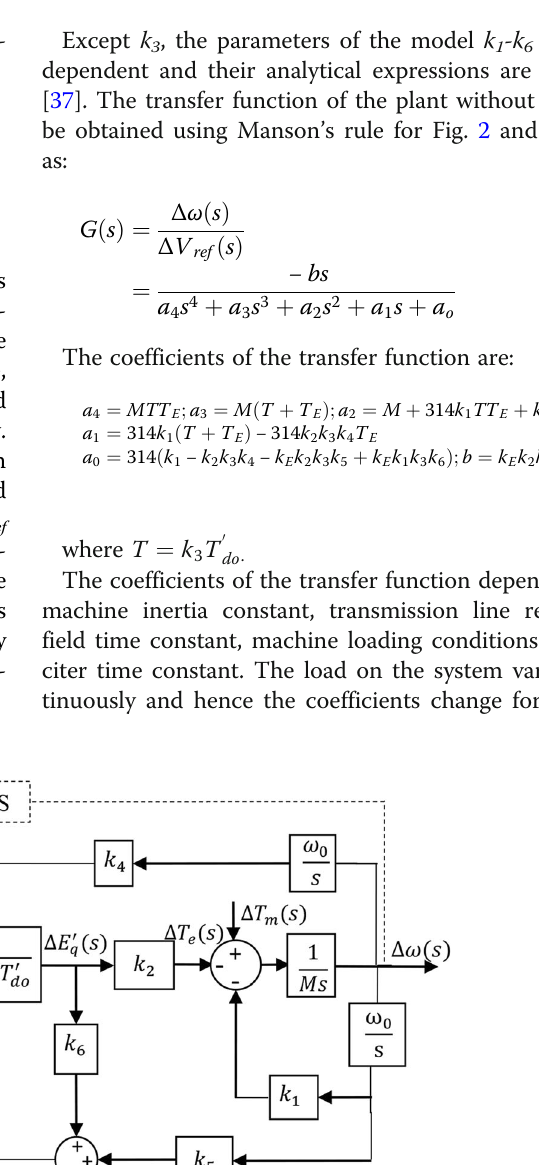
Fig. 1 Basic components of a Single-machine infinite bus power system